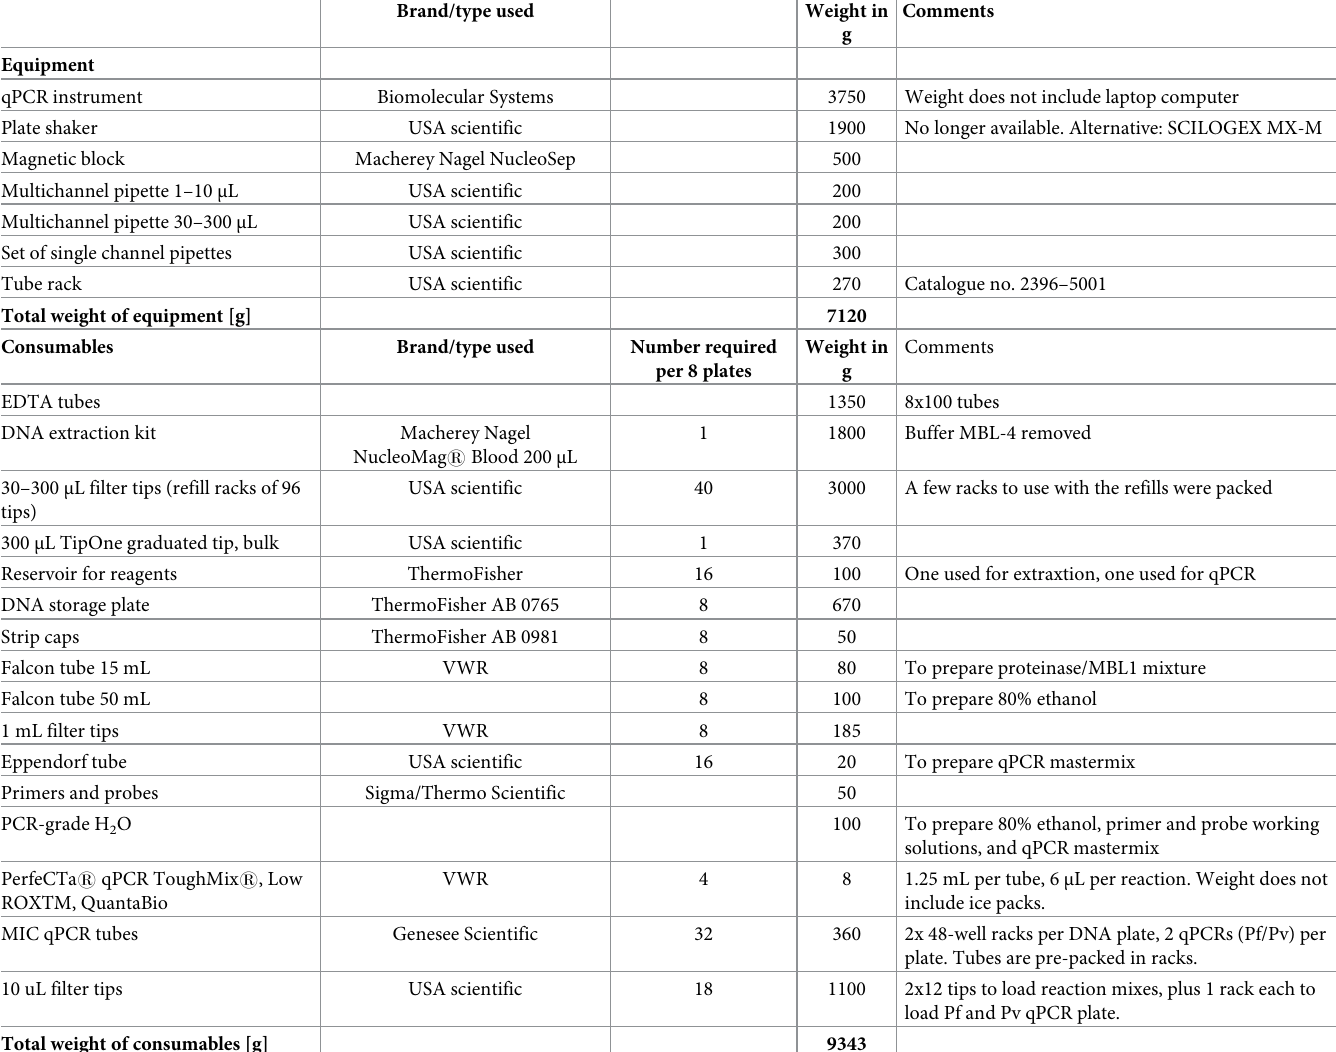
Table 1. Equipment and consumables required for qPCR screening. One extraction kit lasts for 8 x 96-well plates. The number and weight of all consumables and reagents reflects quantities required for 8 x 96 samples. Brand/type